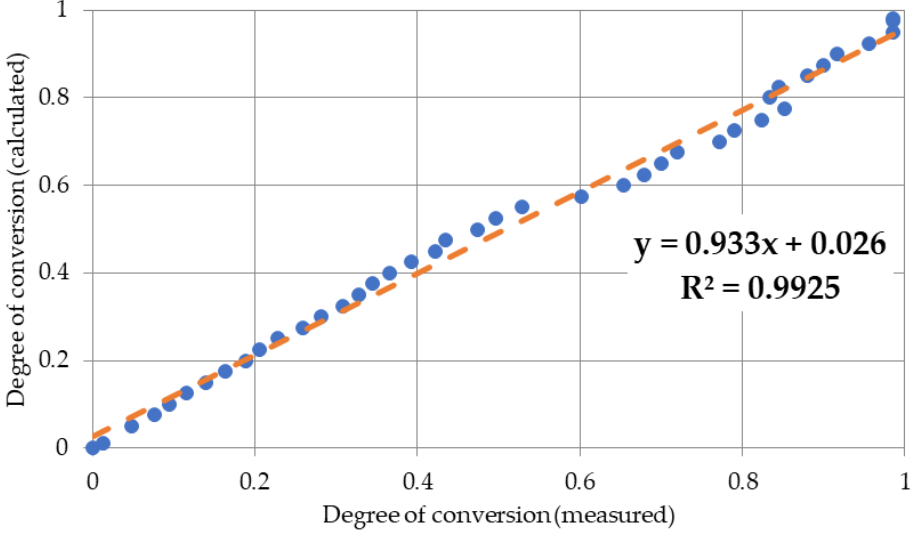
Figure 21. Correlation of the degree of conversion measured and calculated.